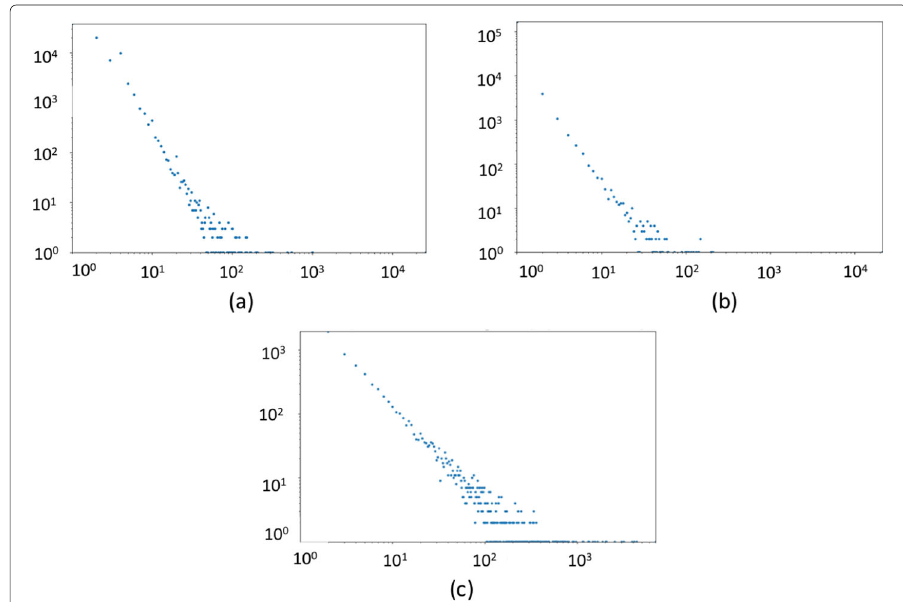
Fig. 10 Connected component size distributions (where size is measured using number of nodes) of higher-order networks. a , b and c respectively refer to networks G ∗ o , G o o , and G i o . The x-axis is the size of the component in terms of the number of nodes, and the y-axis is the frequency of the